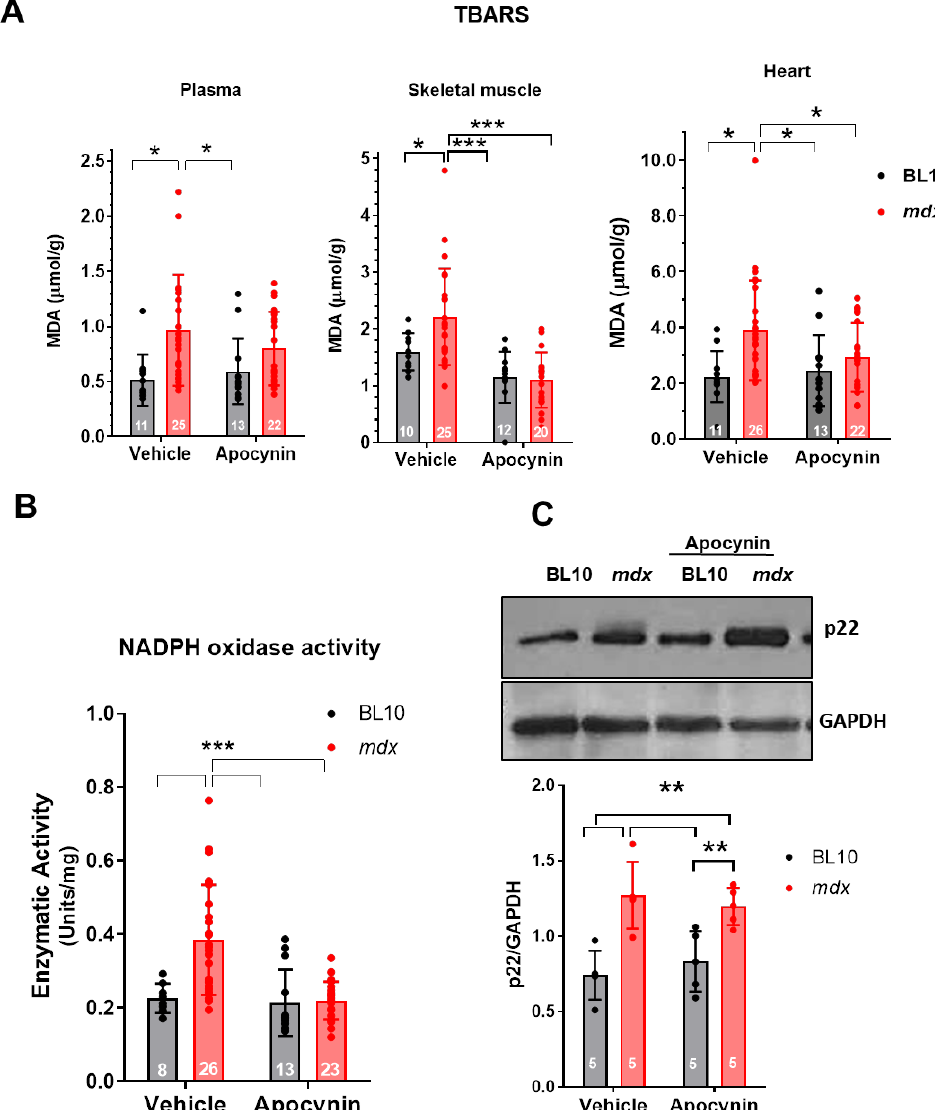
Figure 2. Apocynin treatment reduces NADPH oxidase activity and oxidative stress in dystrophic mice. ( A ) Graphs showing the levels of thiobarbituric acid-reactive substances (TBARS), measured as malondialdehyde (MDA) content in plasma, skeletal muscle and heart from Bl10 and mdx mice, treated with the vehicle or apocynin for one month. ( B ) NADPH oxidase activity, measured as cytochrome-C reduction activity, in cardiac homogenates from BL10 and mdx mice, treated with the vehicle or apocynin. ( C ) Western blot analysis of the levels of p22 in cardiac homogenates from BL10 and mdx mice, treated with the vehicle or apocynin for one month. The n is indicated in each bar of the graphs. Asterisks *, **, ***, indicate p < 0.05, 0.005 or 0.001 for comparisons the indicated by the brackets, ANOVA followed by Newman–Keuls as post-hoc test.